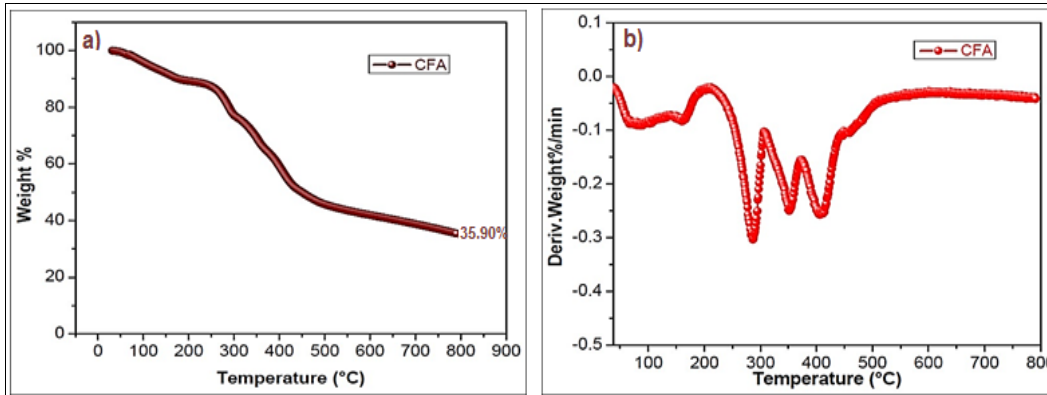
Figure 4. CFA curves ( a ) thermogravimetric analysis TGA and ( b ) DTG. Coatings 2020 , 10 , x FOR PEER REVIEW